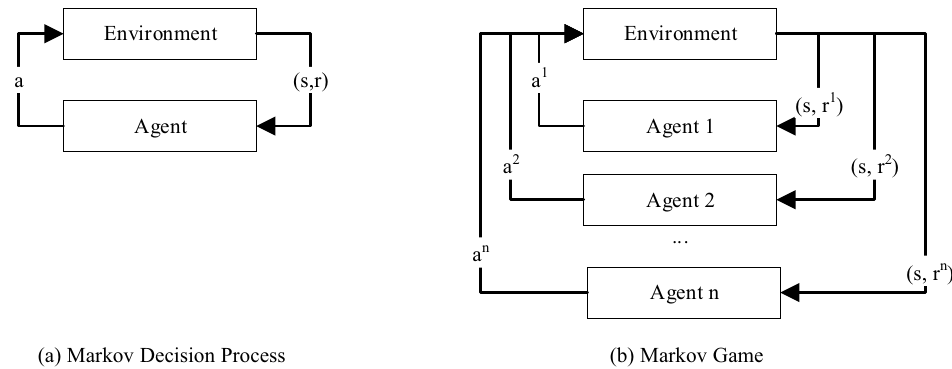
Figure 2. Comparison of the general models MDP ( a ), describing a single-agent-system, and MG ( b ), describing multi-agent systems, according to